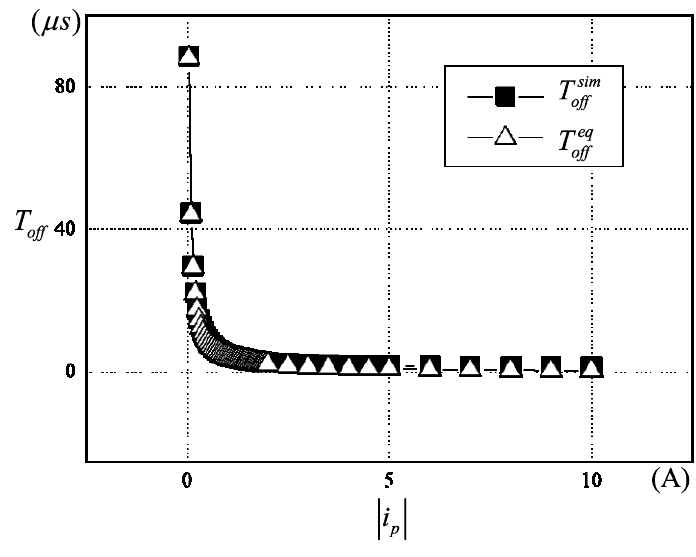
Figure 6. Comparing T eq